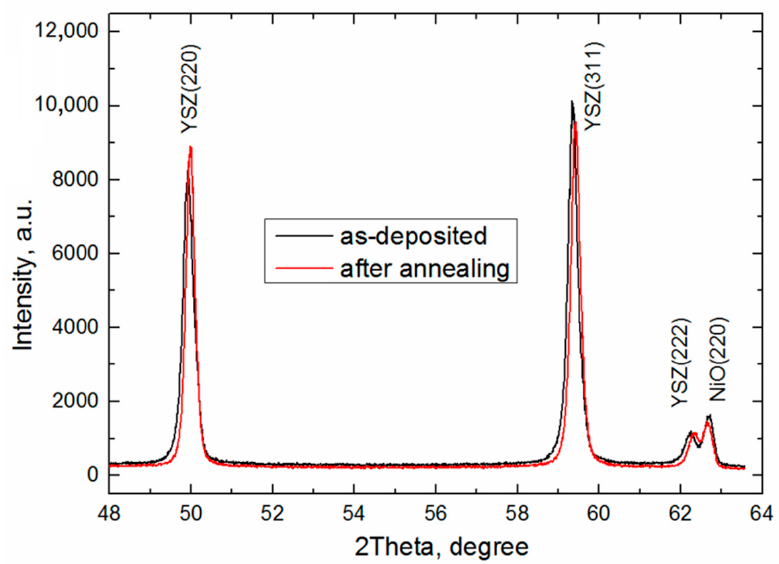
Figure 10. Peak shift in X-ray diffraction of YSZ film (SOFC 2) before (black) and after (red) 1300 ◦ C annealing in air.